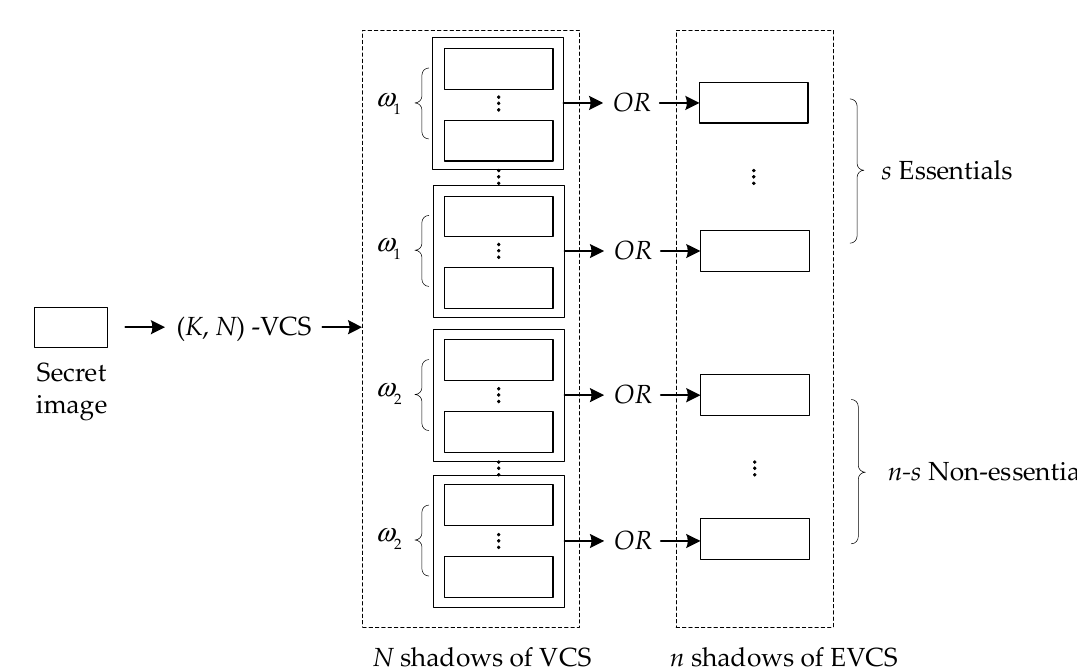
Figure 3. The diagrammatical representation of the proposed ( t , s, k , n )-EVCS.